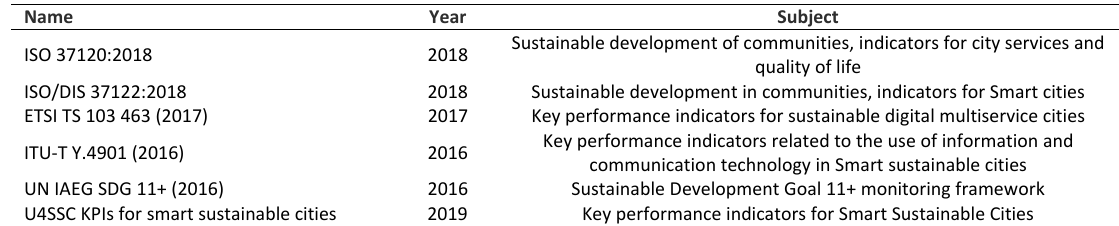
Table 2: The Summary of indicator on Smart sustainable cities from various sources